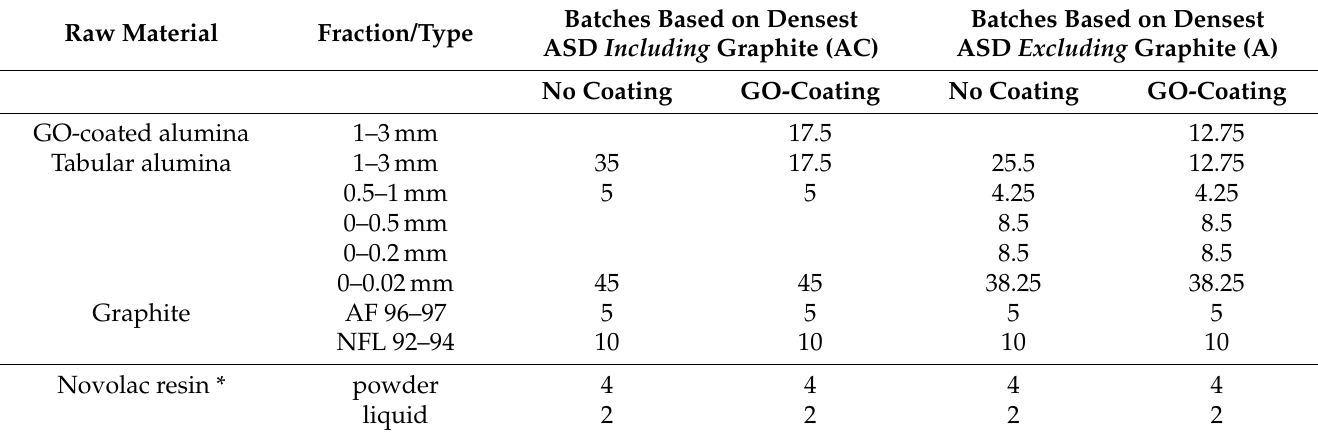
Table 2. Batch compositions in wt% (ASD—aggregate size distribution and GO—graphene